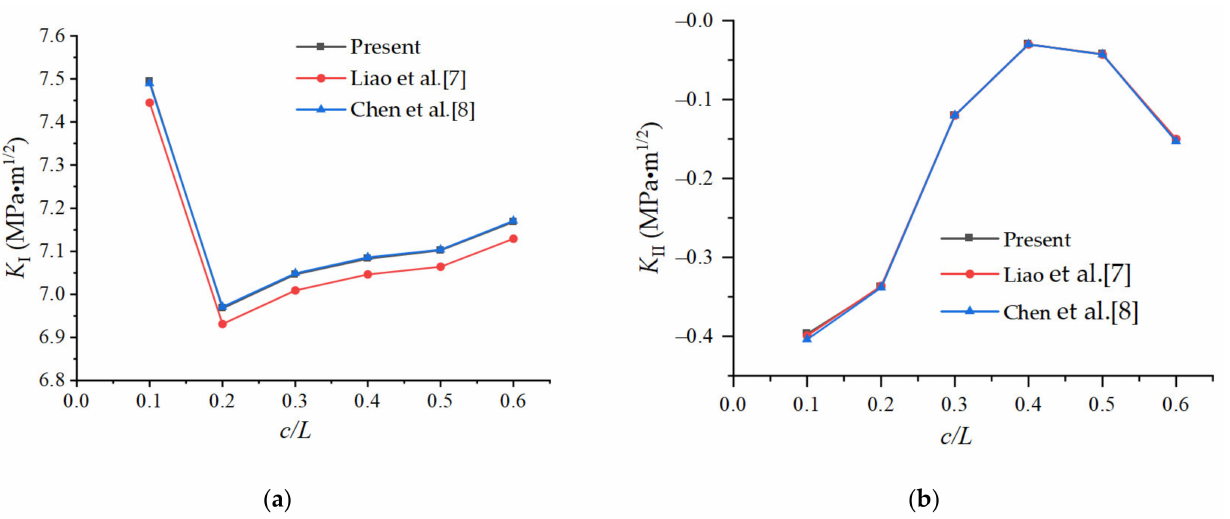
Figure 8. SIFs for different crack spacing ( L / W = 3): ( a ) SIFs K I ; ( b ) SIFs K II